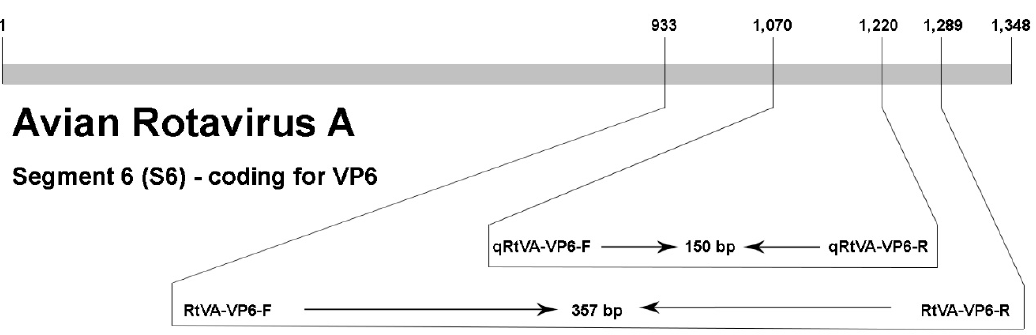
Figure 1. Diagram of segment S6 of ARtV-A, indicating the position of the primers used for RT-PCR and RT-qPCR within the nucleotide sequence. F: forward, R: reverse, bp: base pair.